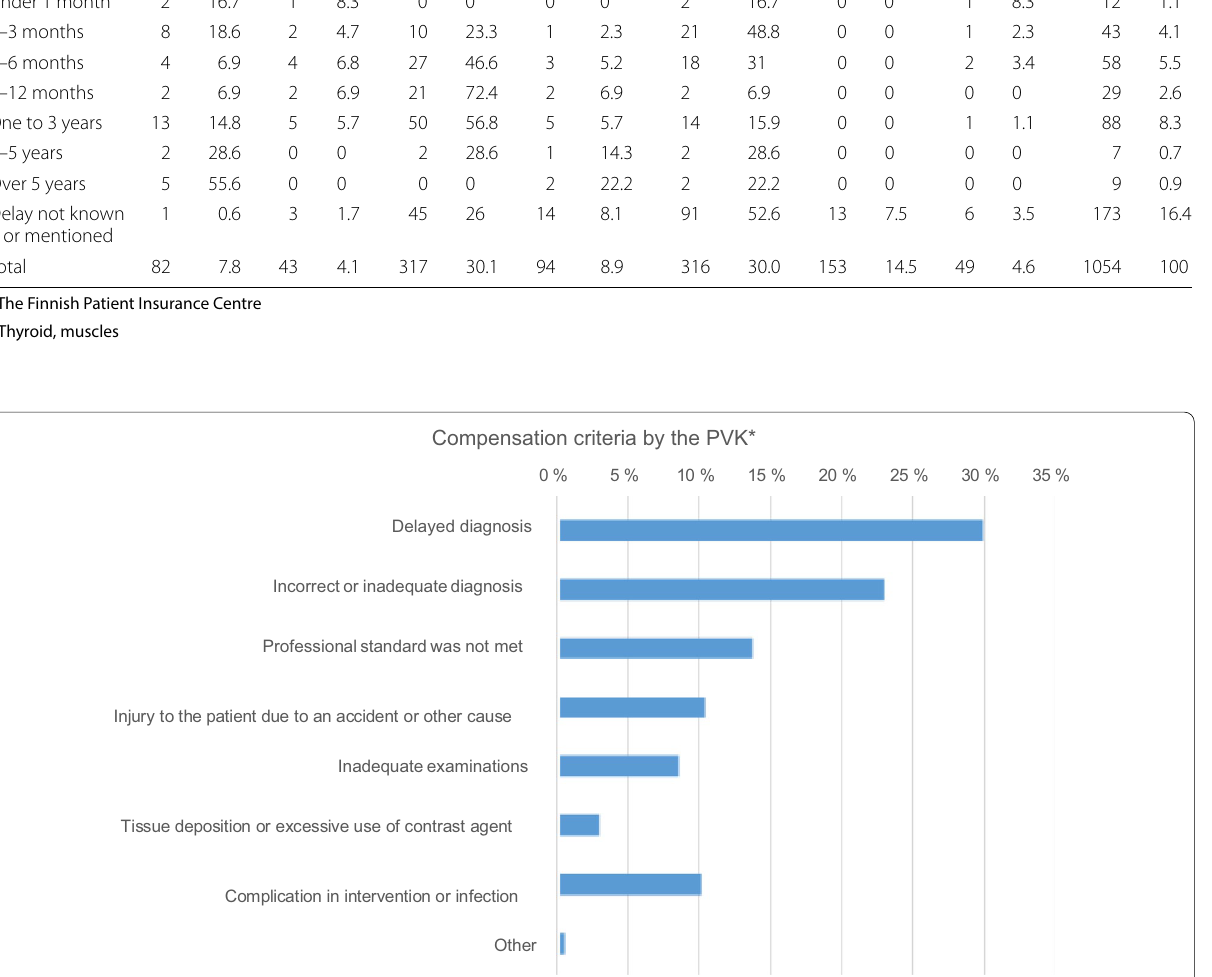
Fig. 3 Medical grounds for compensation criteria by